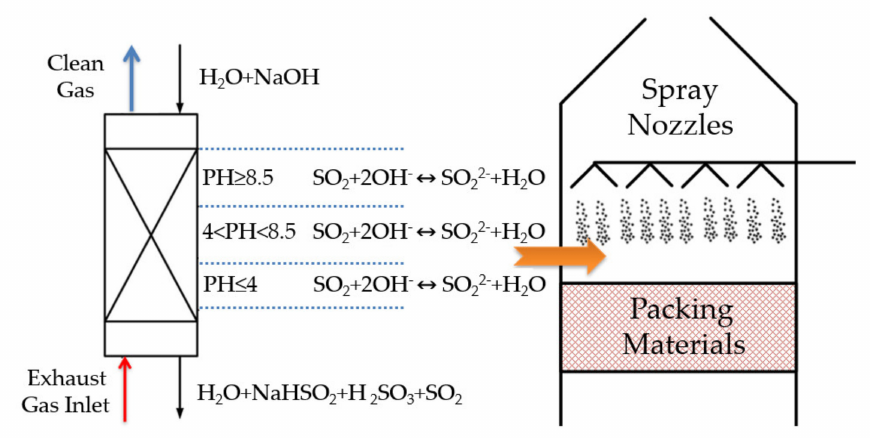
Figure 1. A simplified model of the SO 2 absorption